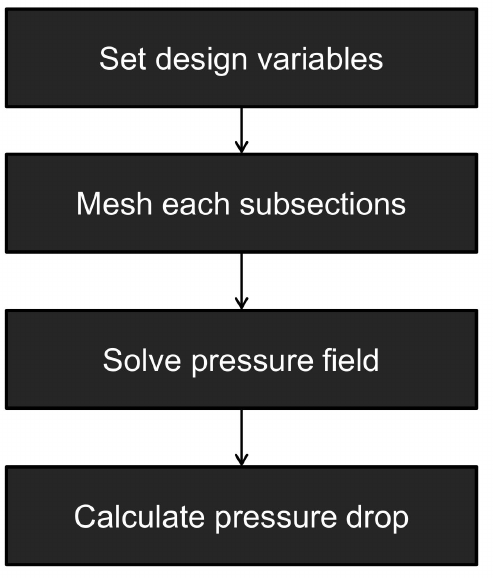
Figure 4. Procedures of pressure drop calculation.